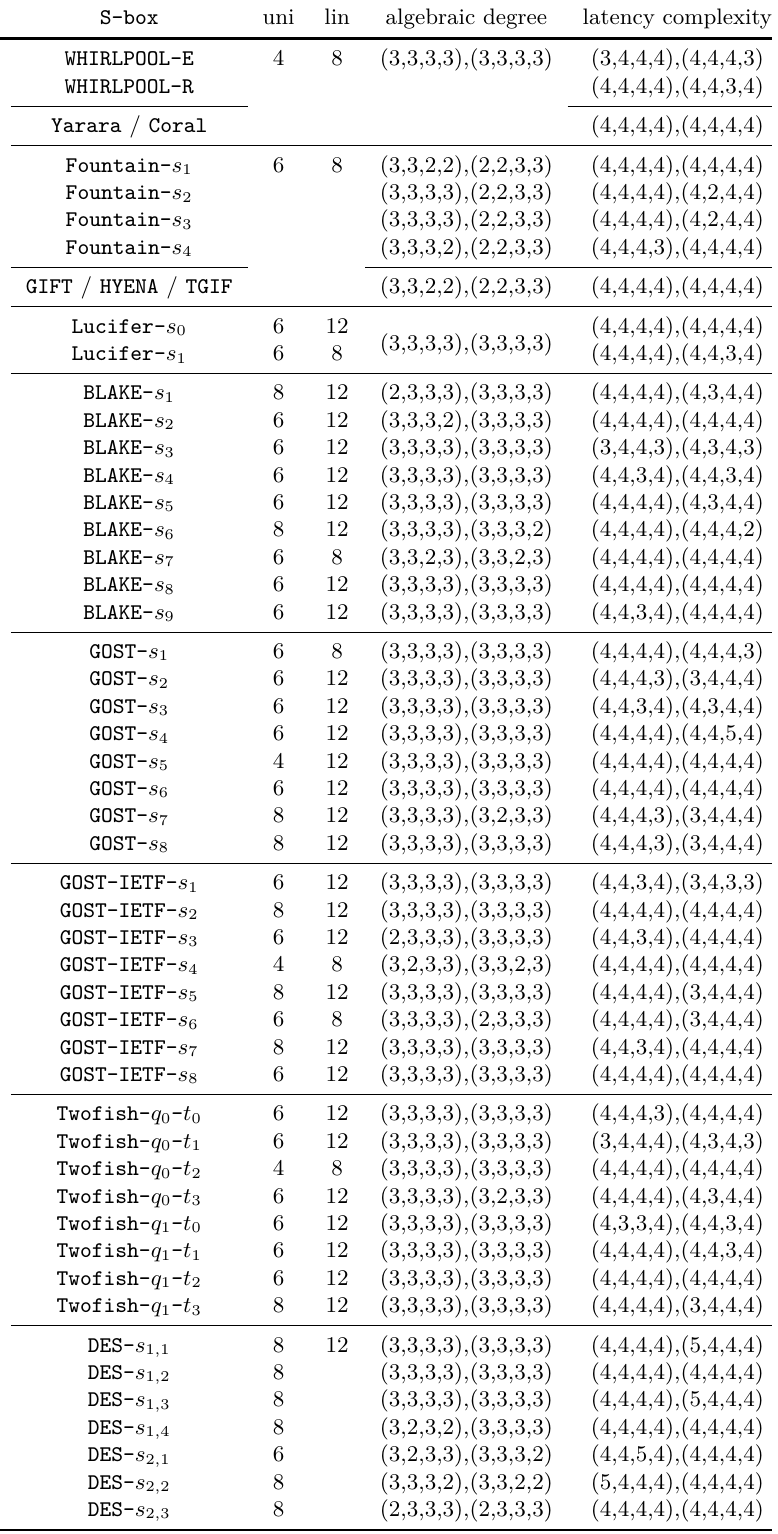
Table 7: Latency Complexity of Known S-boxes